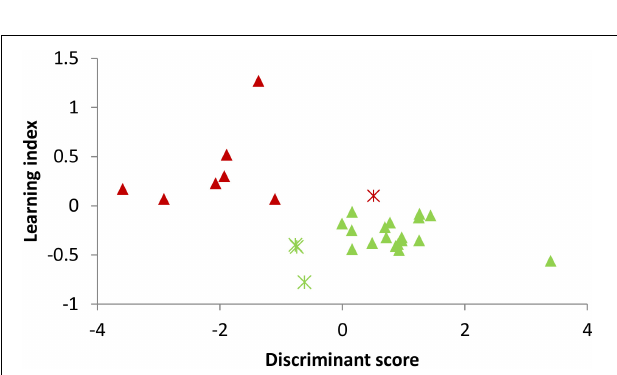
FIGURE 2 | The participants’ discriminant scores and the prediction results of learners and non-learners. Each dot represents the discriminant score of each participant. Green triangle: learner with correct prediction; Green asterisk: learner with wrong prediction; Red triangle: non-learner with correct prediction; and Red asterisk: non-learner with wrong